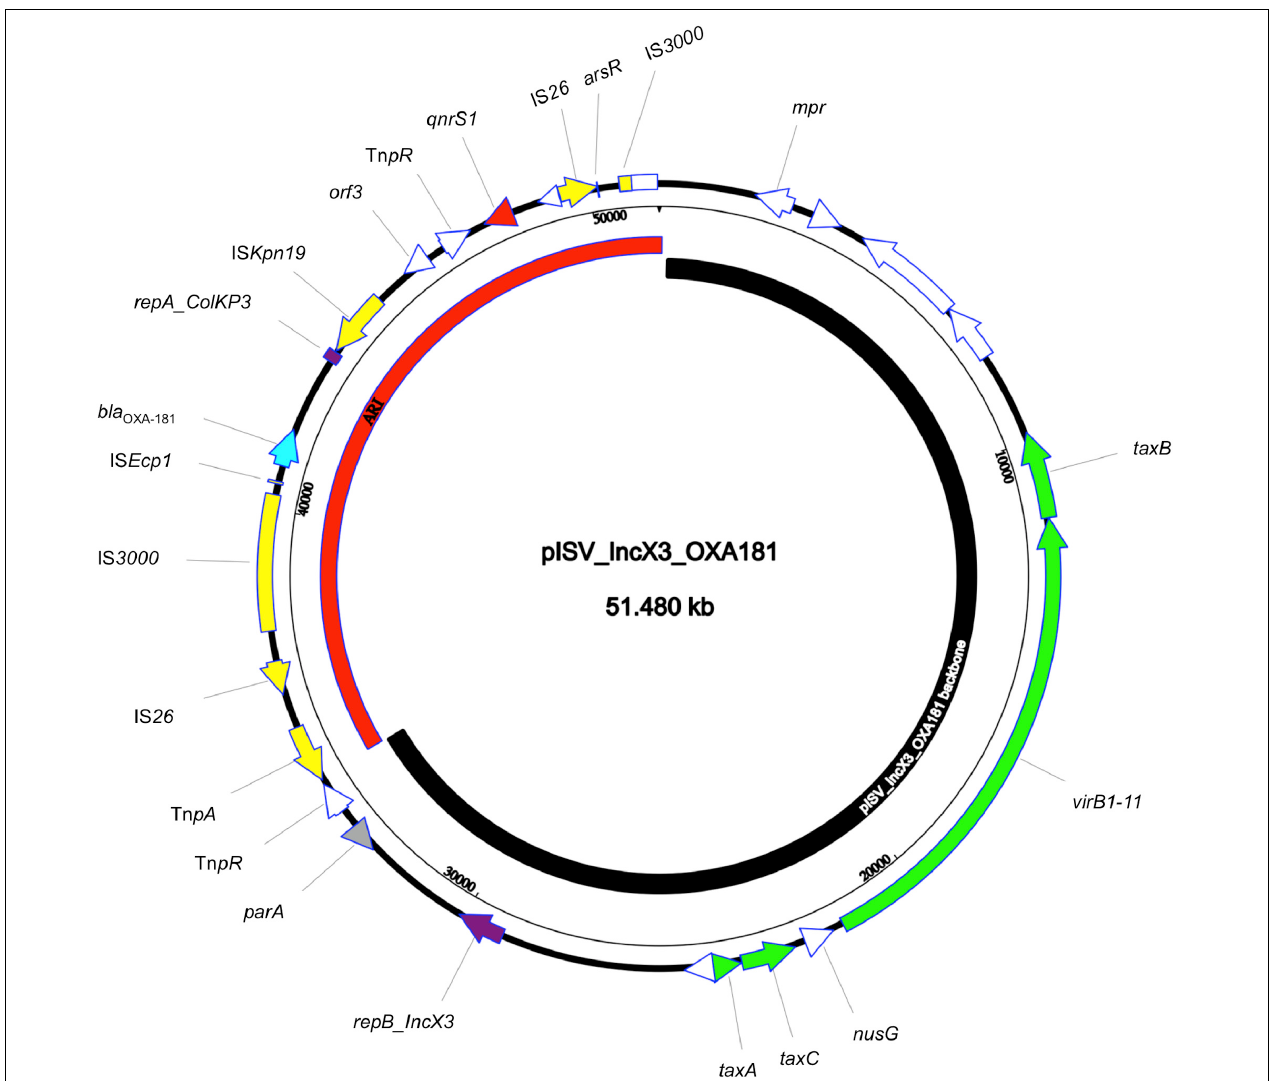
FIGURE 3 | Circular map of pISV_IncX3_OXA181 plasmid; green arrows represent conjugal transfer system of the plasmid, red arrow represents the qnrS1 gene, blue arrow represents the bla OXA - 181 gene, yellow arrows/boxes represent complete/truncated mobile elements, white arrows/boxes represent complete/truncated hypothetical proteins, purple arrows/boxes represent complete/truncated replication protein. Further more, the black inner-curved box represents the plasmid backbone while the red one represents the plasmid Antibiotic Resistance Island